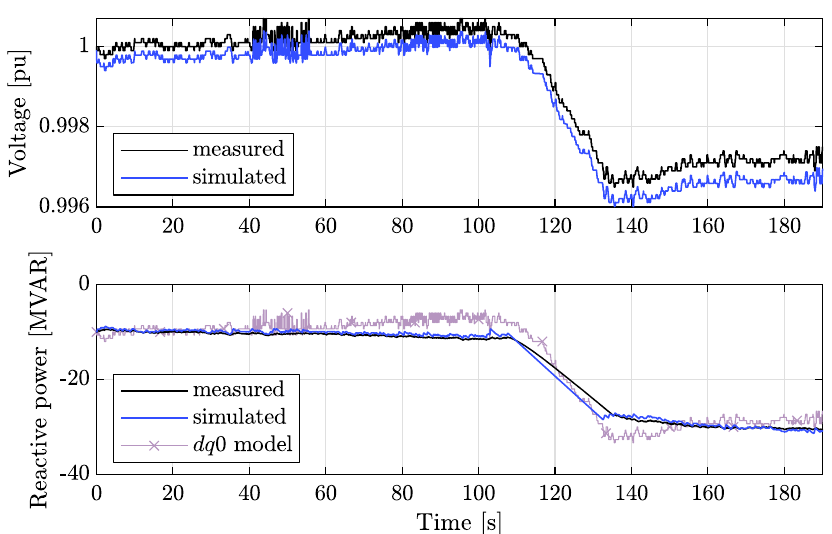
Figure 9. Volt/VAR Control Experiment 1: voltage reference step test. Comparison of simulations and experimental results. The voltage set-point was changed from 1.0 p.u. to 0.997 p.u.